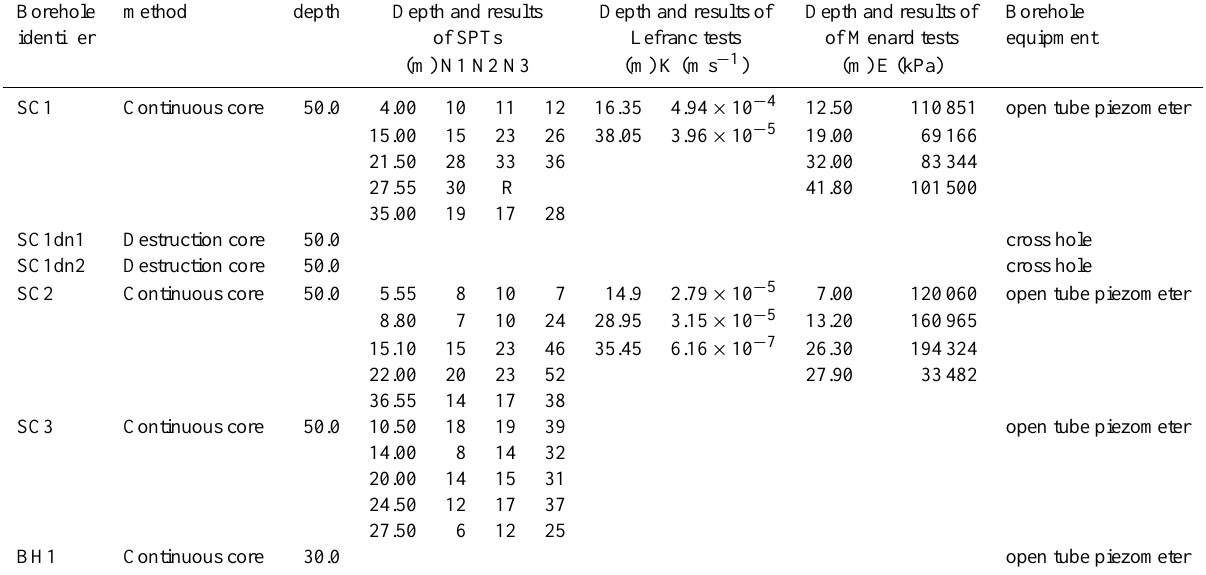
Continuous core 30.0 open tube